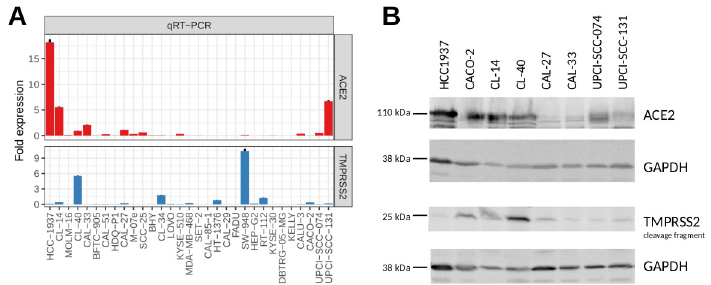
Fig 2. Verified presence of ACE2 and TMPRSS2 in carcinoma cell lines determined by qRT-PCR and western blots. A: Quantification of ACE2 and TMPRSS2 transcripts in the selected candidate cell lines by qRT-PCR (normalised to CAL-27 and CL-40). B: Western blot analysis was performed to assess the expression of proteins associated with SARS-CoV-2 cell entry.